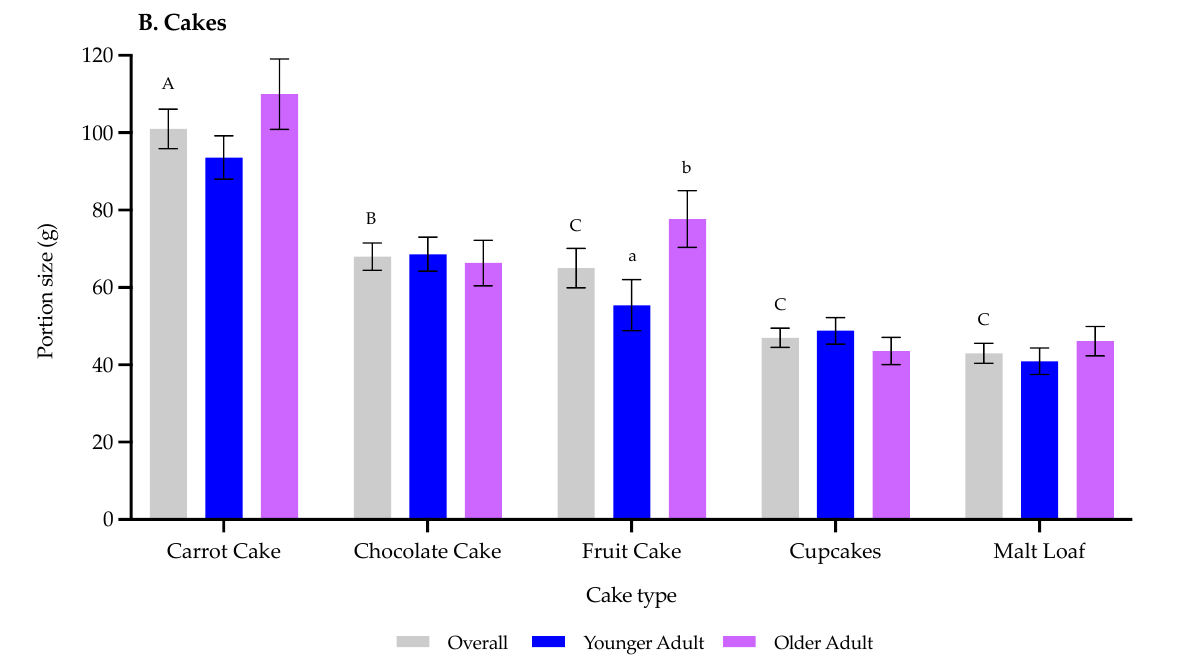
Figure 4. Consumers’ ( n = 73) ideal portion size relating to ( A ) drinks and ( B ) cakes by type and age (younger adults n = 41 and older adults n = 32). Data expressed as means ± standard error. Differing letters reflect significance in preferred portion size as follows: (i) drink and cake types (capital letters) from Kruskal-Wallis and (ii) younger and older adults (small letters) via Mann-Whitney.